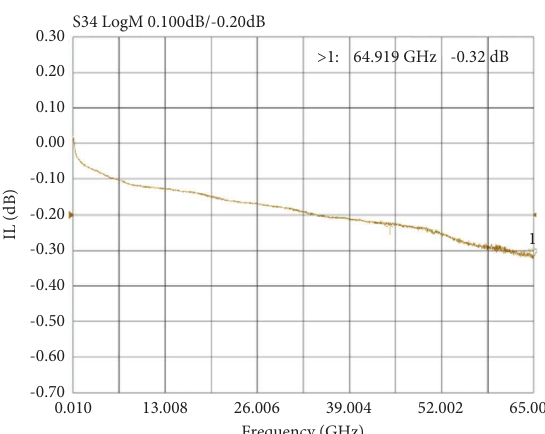
Figure 10: Measured IL curve of the connector.